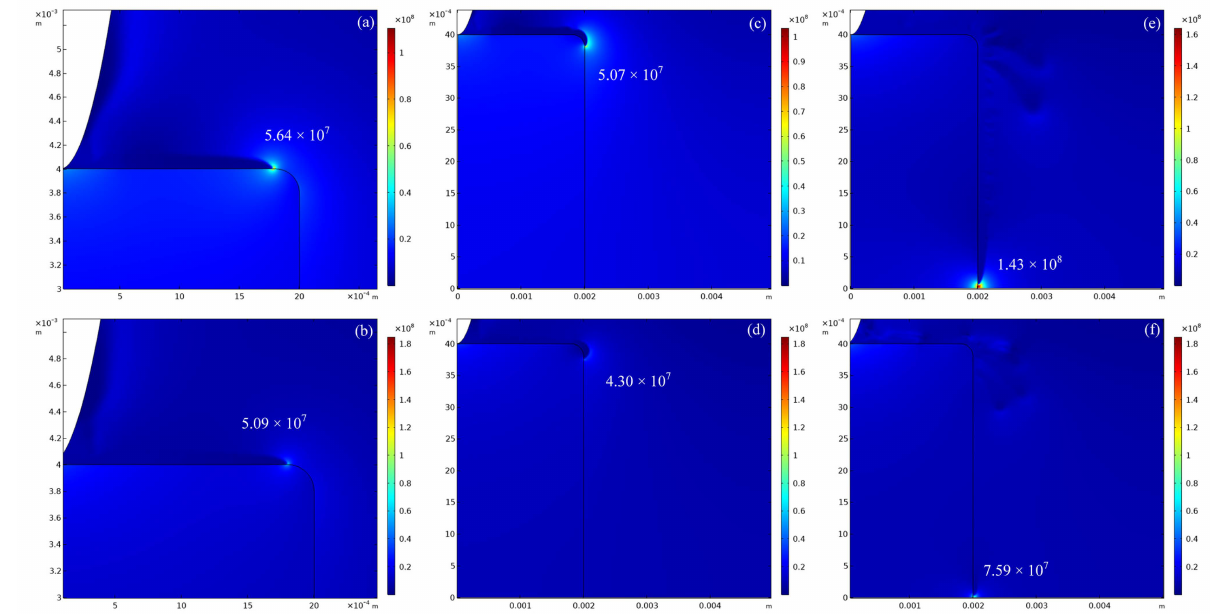
Figure 15. Comparison of the electric field intensity of surface discharge in C 4 F 7 N/CO 2 and SF 6 :